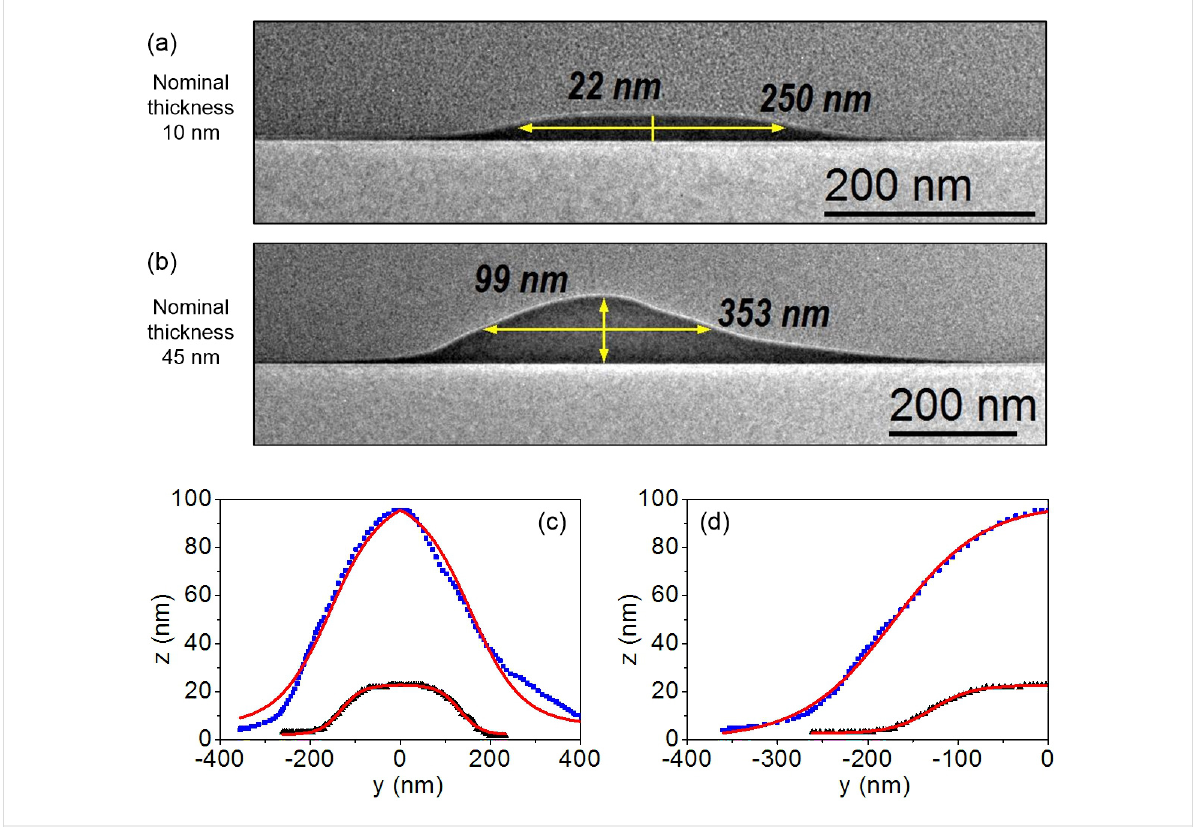
Figure 3: Low-magnification TEM images of the iron nanowires with width of 250 nm and nominal thickness of (a) 10 and (b) 45 nm. Fitting of the (c) full and (d) half profiles of both nanowires using Equation